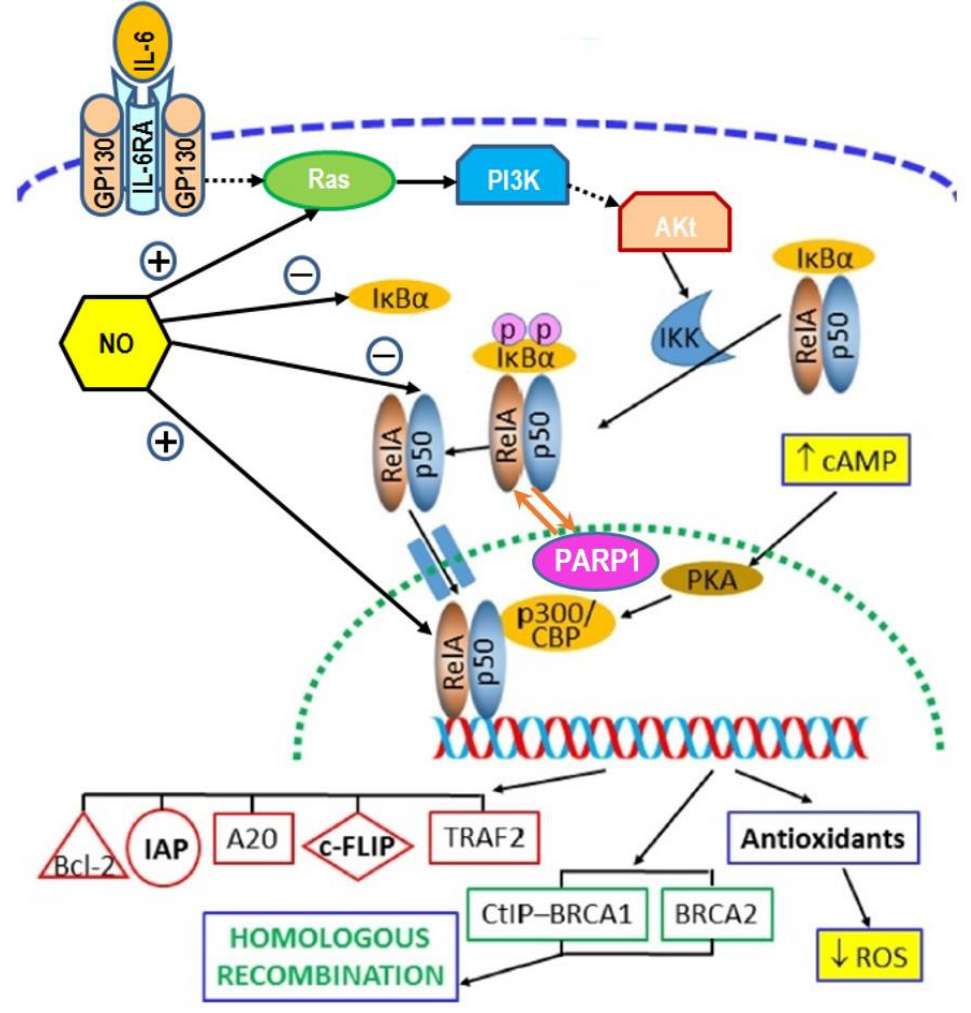
Figure 2. Summary of mechanisms and chemical messengers involved in RIRE: blue dashed line: cell membrane; green dotted line: nuclear envelope; dotted arrows: multiple steps involved. IL-6: interleukin 6; IL-6RA: interleukin 6 receptor alpha; RelA (p65) and p50: NF- κ B family members (chosen for illustration here); NF- κ B: nuclear factor κ B; PARP1: poly (ADP-ribose) polymerase 1; cAMP: cyclic adenosine monophosphate; ROS: reactive oxygen species; NO: nitric oxide; GP130: glycoprotein 130; PI3K: phosphatidylinositol 3-kinase; Akt: protein kinase B (PKB); IKK: I κ B-kinase; PKA: protein kinase A; CBP: CREB-binding protein; CREB: bcl-2: B-cell lymphoma 2 protein; IAP: inhibitors of apoptosis protein; A20: A20 zinc finger protein; c-FLIP: Cellular FLICE-like inhibitory protein; FLICE: FADD-like interleukin-1 β -converting enzyme; FADD: Fas-associated protein with death domain; TRAF2: TNF receptor-associated factor 2; CtIP: C-terminal binding protein (CtBP)- interacting protein; BRCA1: breast cancer type 1 susceptibility protein; BRCA2: breast cancer type 2 susceptibility protein. (Adopted from ref. [20]; permission to reuse obtained from